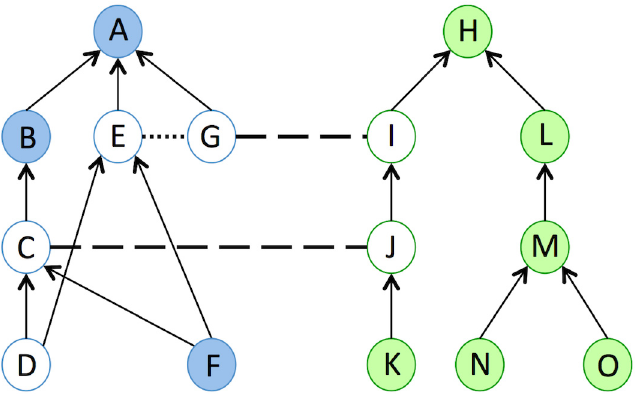
Fig 1. Example of an alignment between two ontologies (blue and green). Circles represent classes, arrows represent subclass relationships between classes, dashed lines represent mappings between classes, and dotted lines represent disjointness restrictions between classes. The circles filled in white represent the classes in the core fragments of the ontologies given the alignment.